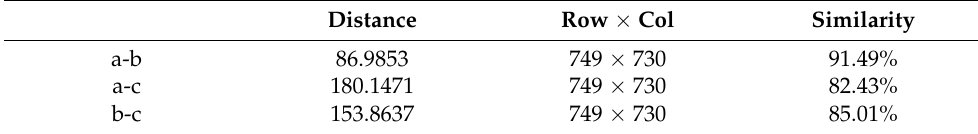
Table 7. Results of three